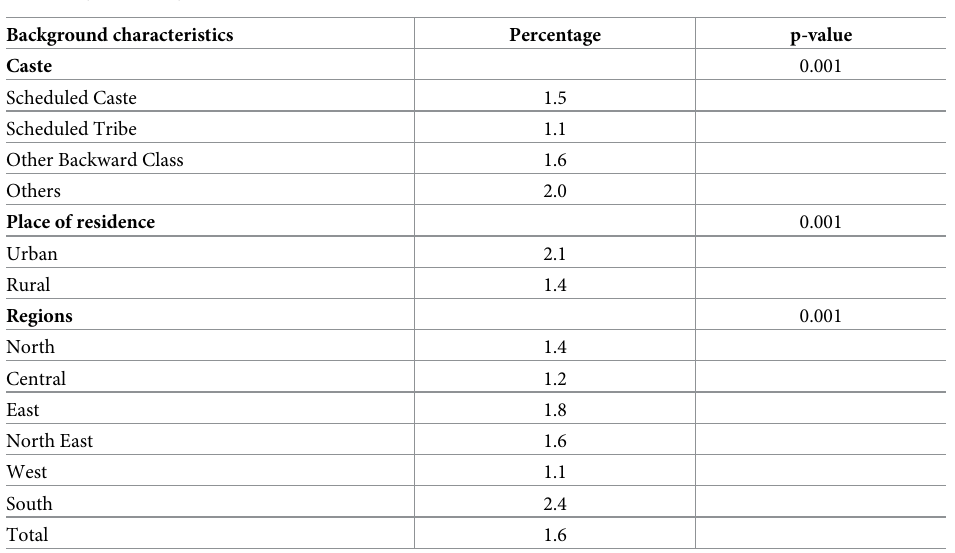
who were not educated. Women who were divorced/separated/widowed had significantly higher odds to suffer from multi-morbidity than women were never married. Women were exposed to media had 19% significantly higher odds to suffer from multi-morbidity than women who were not exposed to media. Obese women had 3.73 times significantly higher odds to suffer from multi-morbidity than women who had normal BMI. Women were smoked tobacco, chew tobacco and consume alcohol had 87%, 18% and 18% significantly higher likeli- hood to suffer from multi-morbidity than their counterparts respectively. Higher the wealth status higher the likelihood of women to suffer from multi-morbidity; that is, women from the richest wealth status were 51% significantly more likely to suffer from multi-morbidity than women from the poorest wealth status. Women from the Muslim religion and the Christian religion had higher odds to suffer from multi-morbidity than women from the Hindu religion. Women from the eastern region, northeastern region and southern region had significantly higher odds to suffer from multi-morbidity than women from northern region.